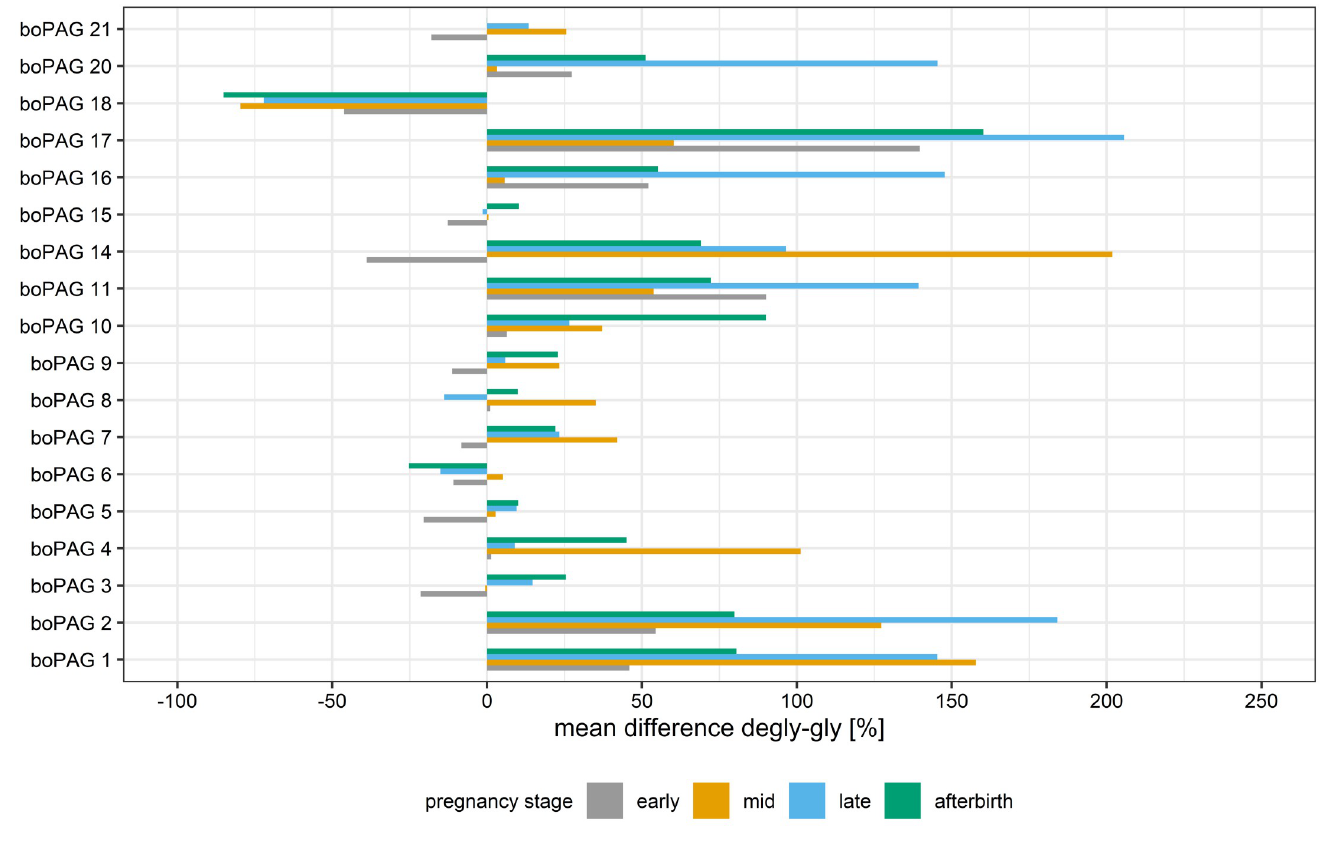
Fig 7. Mean percentage change of Total Area Fragment values from boPAGs between deglycosylated (degly) and glycosylated (gly) samples in the course of pregnancy and post-partum.